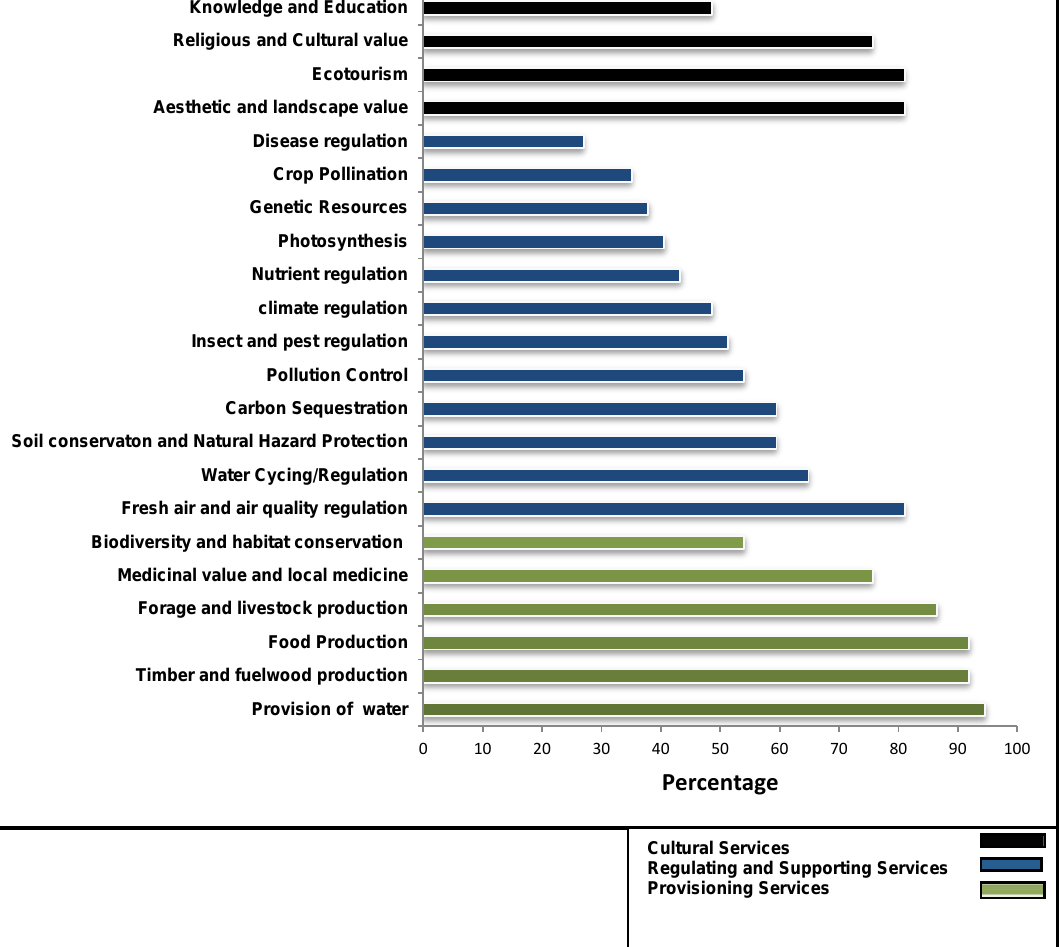
Figure 2. Overall percentage of respondents on the major ES in the PMER.